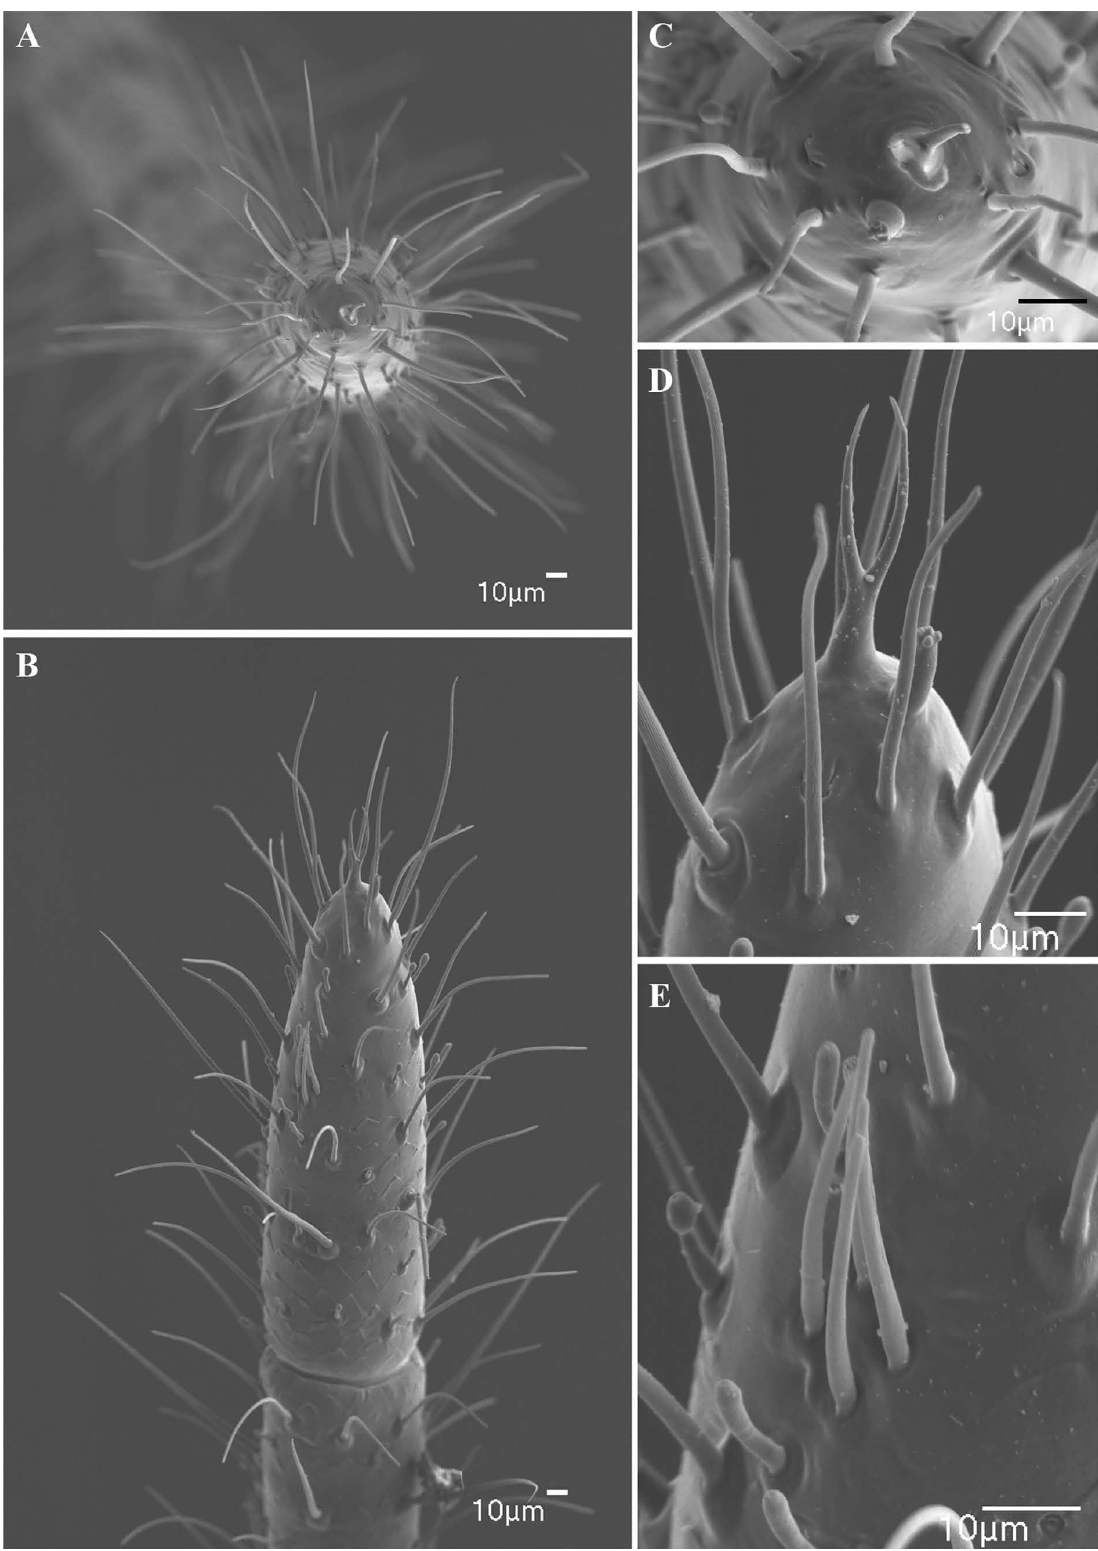
Fig. 46. Charinus alagoanus sp. nov. (MNRJ 9295), antenniform leg I, ♀. A . Apex of distal article. B . Distal segment of tarsus, lateral view. C . Apex of distal article of tarsus showing claw and tarsal organ. D . Detail of claw and tarsal organ. E . Rod sensilla and olfactory